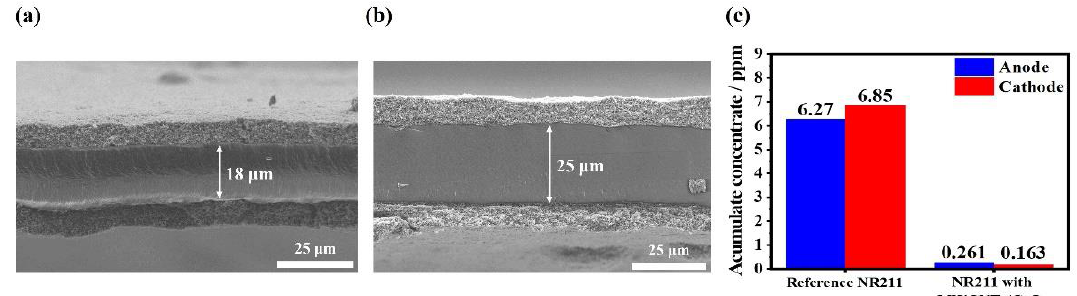
Figure 6. Cross-sectional SEM images of the MEAs with ( a ) the reference NR211 and ( b ) the modified membrane with the MWCNTs/CeO 2 functional layers after the OCV holding test. ( c ) Accumulated concentration of fluoride ions in the drain water after the OCV holding test.